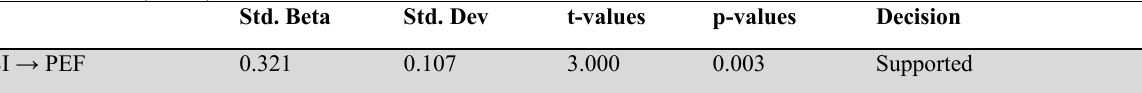
Structural model